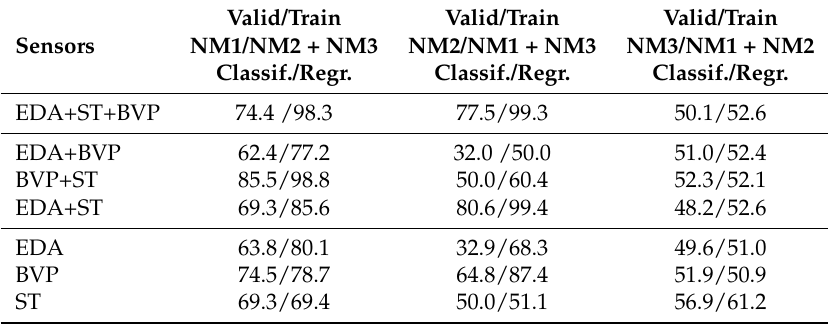
Table 8. Cross-validation of three datasets collected from study subject